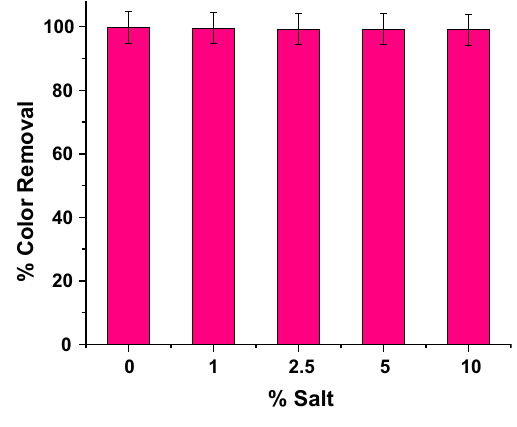
Fig. 4 Effect of salt on removal of EB (dye concentration: 100 mg/L, biomass: 100 mg, 4 h)